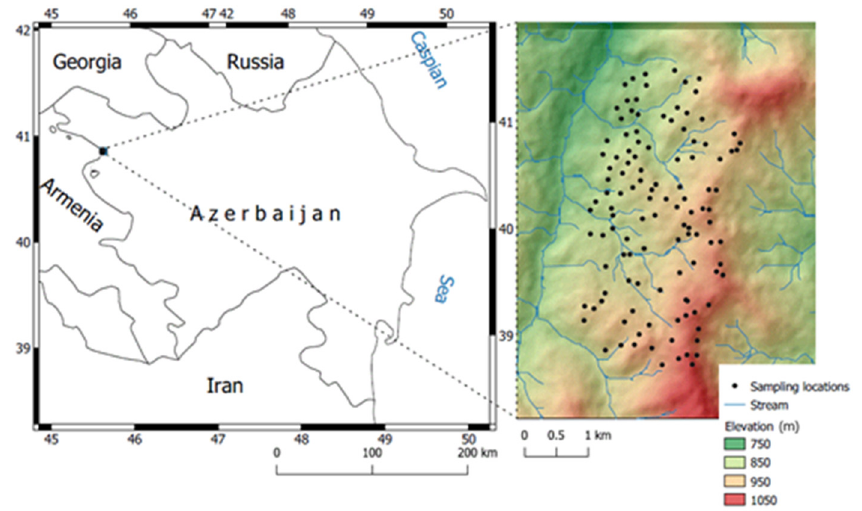
Figure 1. Geographical location of the study area (Digital Elevation Model data (USGS SRTM 1-ArcSecond Global DEM) was downloaded from www.earthexplorer.usgs.gov, accessed on 11 July 2018).